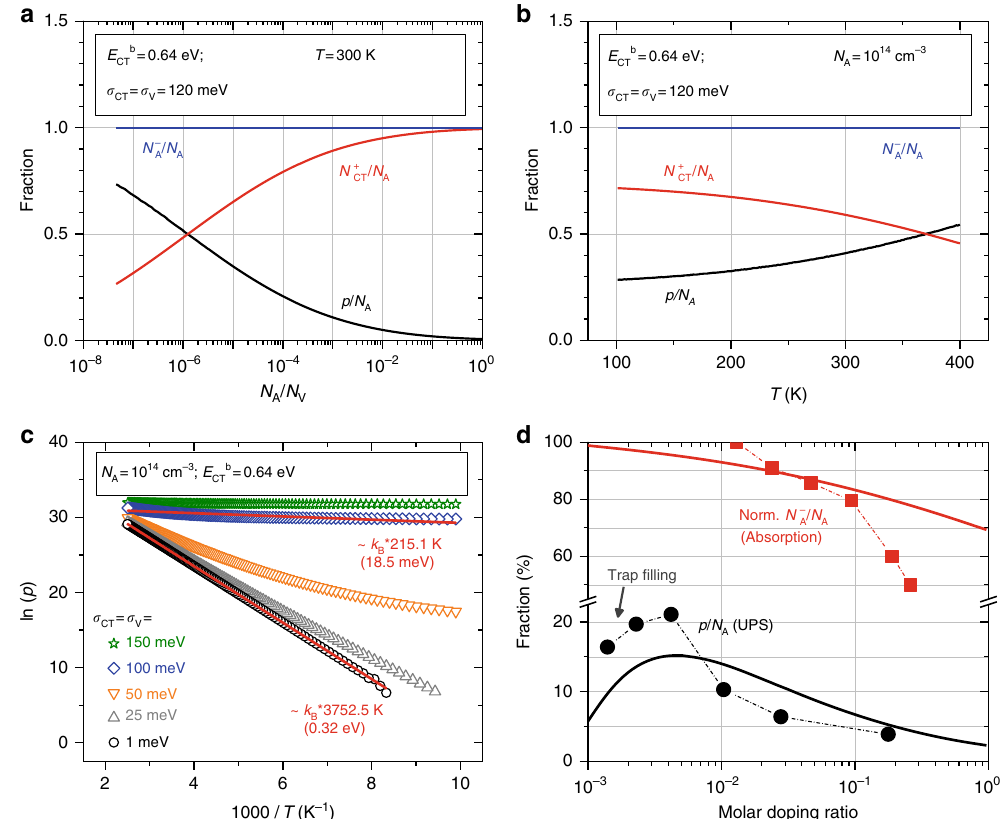
Fig. 4 Linking doping freeze-out and ICTC occupation. a – c Numerical solutions of the neutrality condition Eq. (4) for E CT b = 0.64 eV and N V = 2.4 × 10 19 cm − 3 . d Doping ef fi ciencies p / N A determined by incremental UPS on Ag/MeO-TPD(0.7 nm)/ZnPc(4.5 nm)/ZnPc:F 6 -TCNNQ( x, MR) samples and fraction of ionized acceptors N A − / N A (F 6 -TCNNQ − /F 6 -TCNNQ) estimated from the absorption spectra of Fig. 2. Continuous lines indicate calculations using a three-level model with E CT b = 0.64 eV, E A = 0.25 eV, and σ CT = σ A = σ V = 160 meV, considering trap fi lling